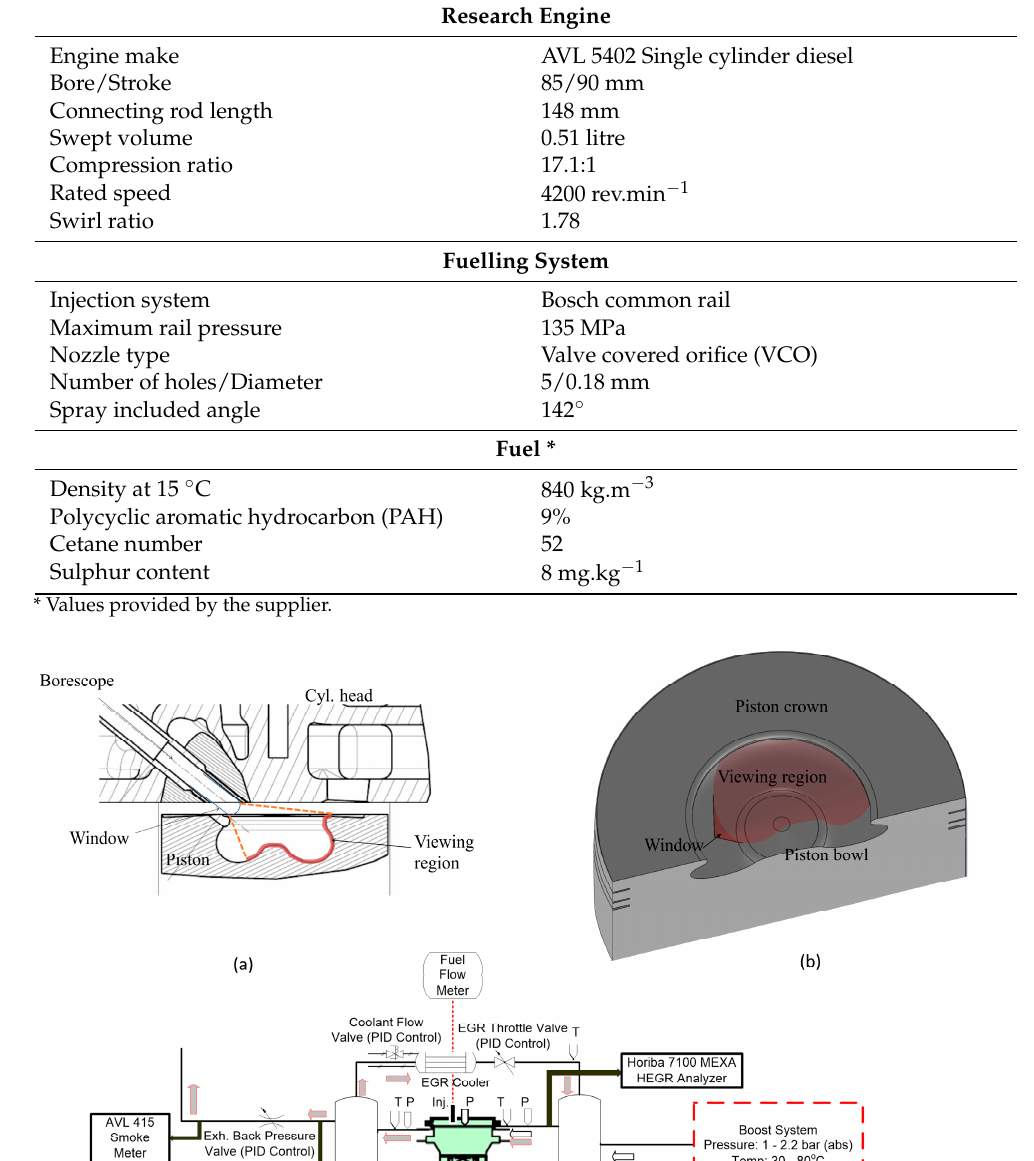
Table 1. Single cylinder research engine and fuelling system specifications.